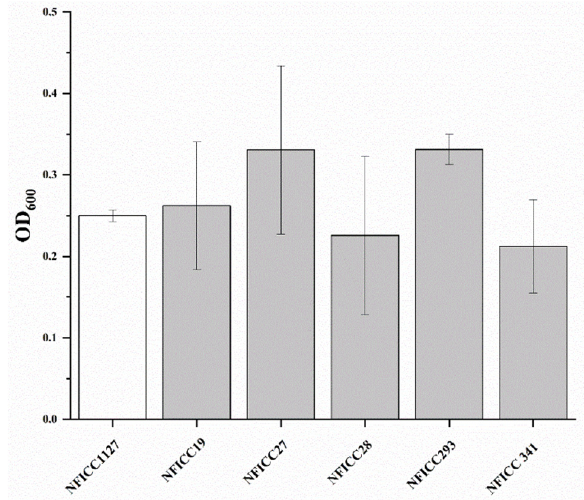
Figure 5. Antibacterial activity of the selected LAB’s cell-free supernatant in Bread Media (BM) on spoilage agent B. amyloquiefaciens NFICC 1127. One-tail t test was performed on the obtained triplicates comparing OD600 value after 48 h growth of NFICC1127 in BM and the same pathogens challenged with CFS of L. plantarum (NFICC19, 27, and 293), Lc. citreum (NFICC28), and P. pentosaceus (NFICC341). No significant differences between the control and treated samples were observed at t(2) = − 2.92 and p = 0.05.